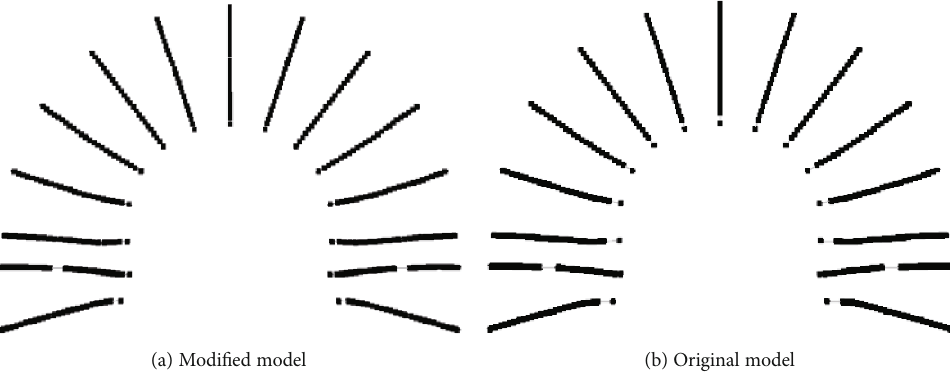
Figure 13: The ultimate state of the structural elements of rock bolts when the modi fi ed model and the original model arrive at the calculation